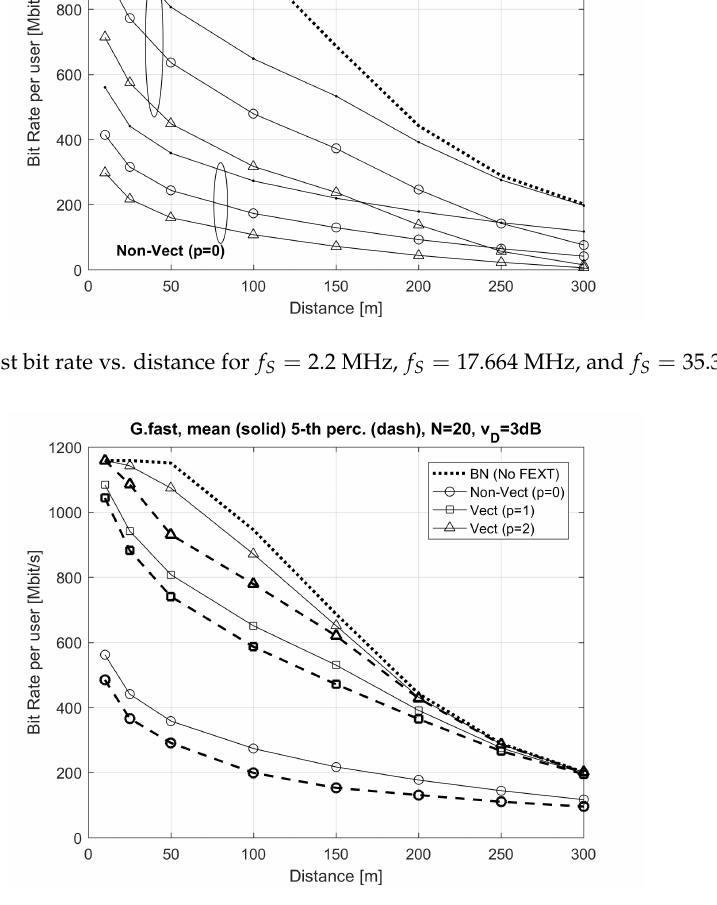
Figure 11. Mean and 5-th percentile in the non-vectoring p = 0 and vectoring cases, with p = 1 and p = 2, for G.fast with N =